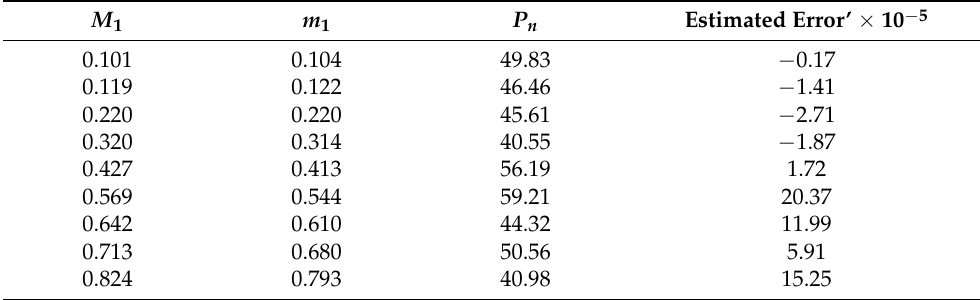
Table 10. The input data for high conversion and r 1 = 0.72 and r 2 = 0.92 (HC2).